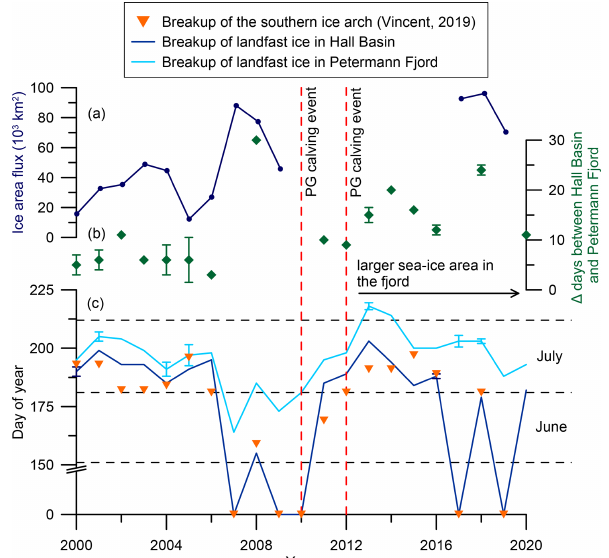
Figure 2. Modern ice arch dynamics in Nares Strait. (a) Annual mean ice area flux through southern Lincoln Sea flux gate (2000– 2009, Kwok et al., 2010; 2017–2019, Moore et al., 2021). (b) Dif- ference between ice breakup in Hall Basin and Petermann Fjord in days. After 2010/2012 the differences increase due to the larger sea ice area in Petermann Fjord following the retreat of the ice tongue. (c) Time series of approximate landfast sea ice breakup in Peter- mann Fjord (light blue) and Hall Basin (dark blue) from 2000–2020 estimated from https://worldview.earthdata.nasa.gov/. The orange triangles represent the day of year when the southern ice arch col- lapsed (Vincent, 2019). Where the Hall Basin and ice arch breakup record have a day of year of zero, landfast sea ice did not form in Nares Strait throughout the entire year. Where cloud cover inhib- ited the exact determination of the day of landfast sea ice breakup, the average between the last clear day with landfast ice and the first clear day following ice breakup was used (Hall Basin: 2000, 2016; Petermann Fjord: 2001, 2004, 2005, 2013, 2017, 2018). Error bars indicate the time span where cloud cover inhibited clear determina- tion of the sea ice state. The dashed vertical lines indicate years of substantial ice tongue calving in Petermann